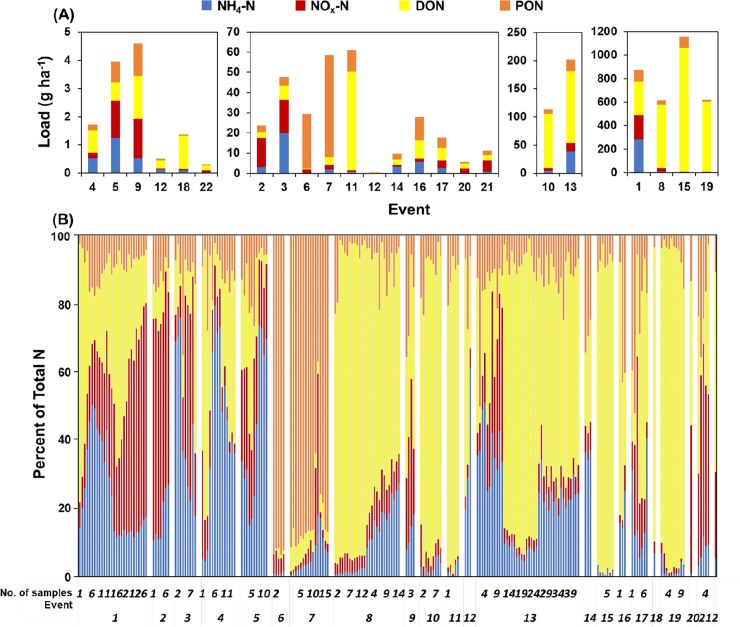
(A) Loads of various nitrogen forms separated into four loading groups and (B) percentage of nitrogen forms in 22 storm events from May to September 2016.